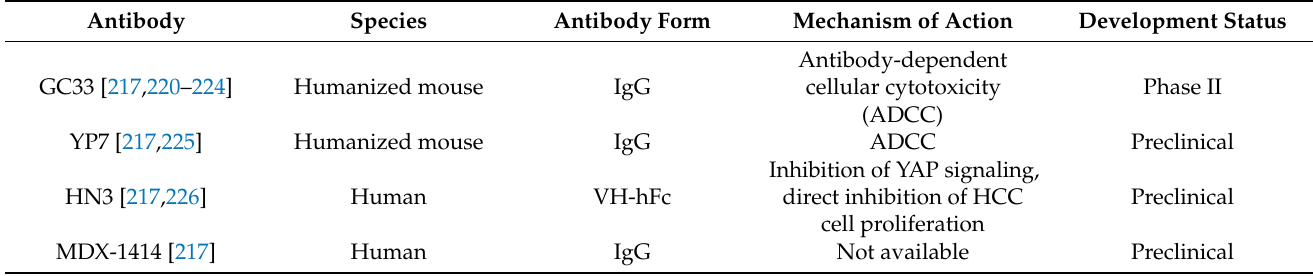
Table 2. Summary of the various GPC3-targeting antibodies currently under research.